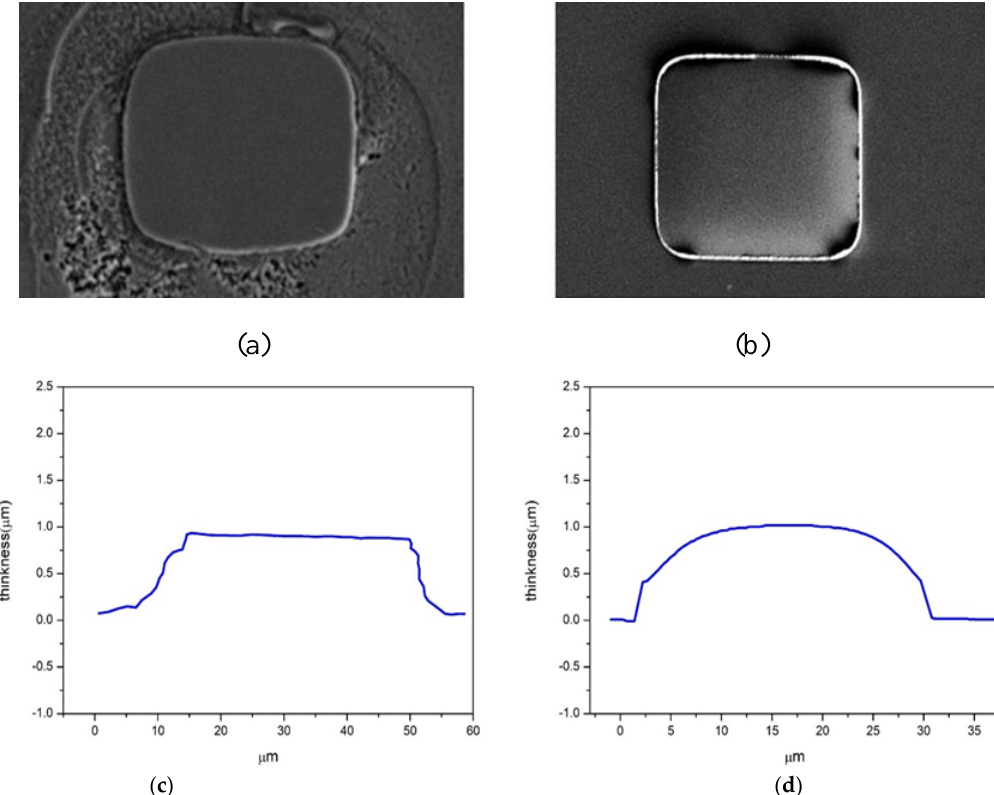
Figure 12. LSB: ( a ) top-down view of the subtractive Al bump; ( b ) top-down view of the additive Al bump; and cross- sectional atomic force microscopy scans of the ( c ) subtractive Al bump and ( d ) additive Al bump.